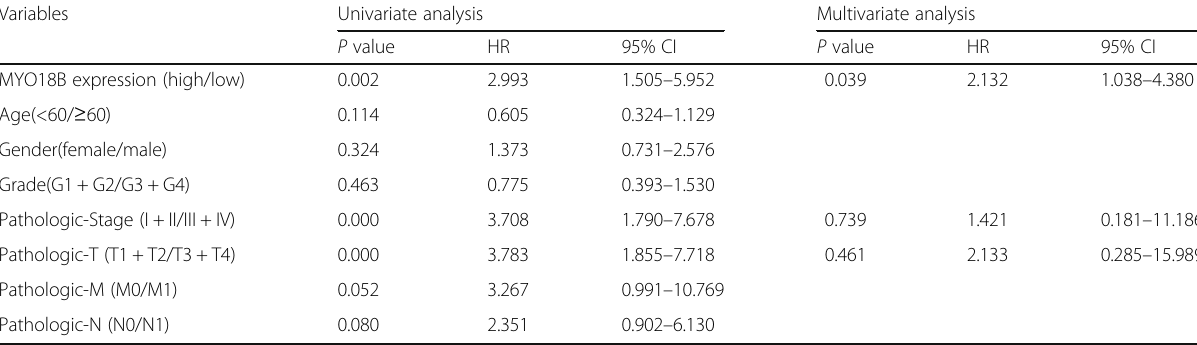
Table 2 Cox regression analysis of overall survival in patients with hepatocellular carcinoma